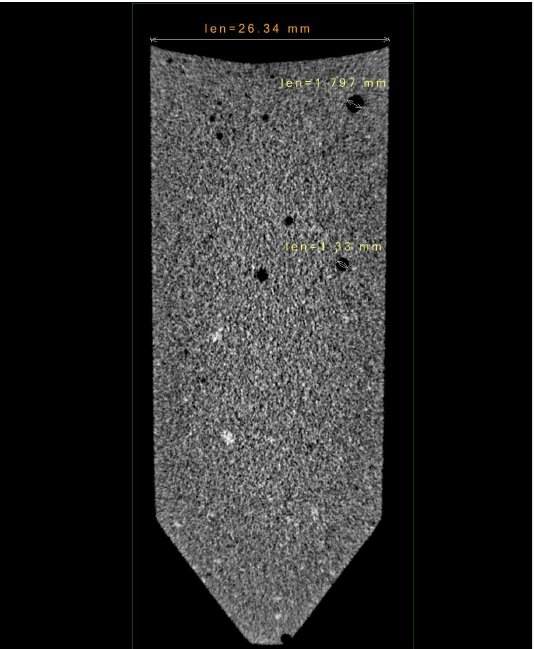
Figure 8. X-ray computed tomography. The scan resolution is 60µm 3